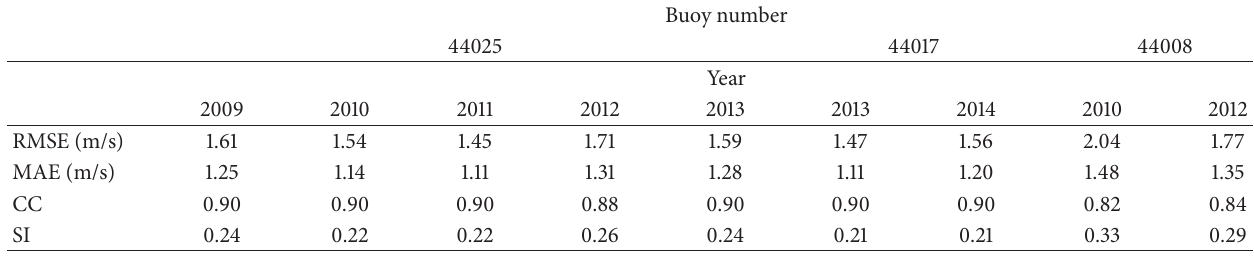
Table 4: Performances of wind speed estimation from different buoys in different years by the ANN trained with the buoy data of 2008.